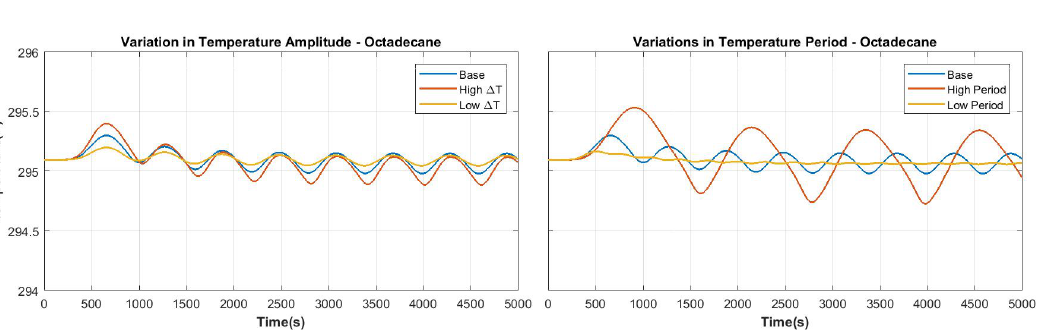
Figure 13. Results of N-octadecane at Re = 1000 with amplitudes of 10, 20, 30 K and periods of 5, 10, 20 min. Octadecane remains at all times in a semi-phase changed state, when the oscillation range is increased the top end of the temperature variations remain similar due to the constant temperature phase change. The high period case showed very constant PCM activity, whereas the low period case showed very rapid swings in PCM use. In all cases the absolute change in oscillation remains small with oscillations less than 1